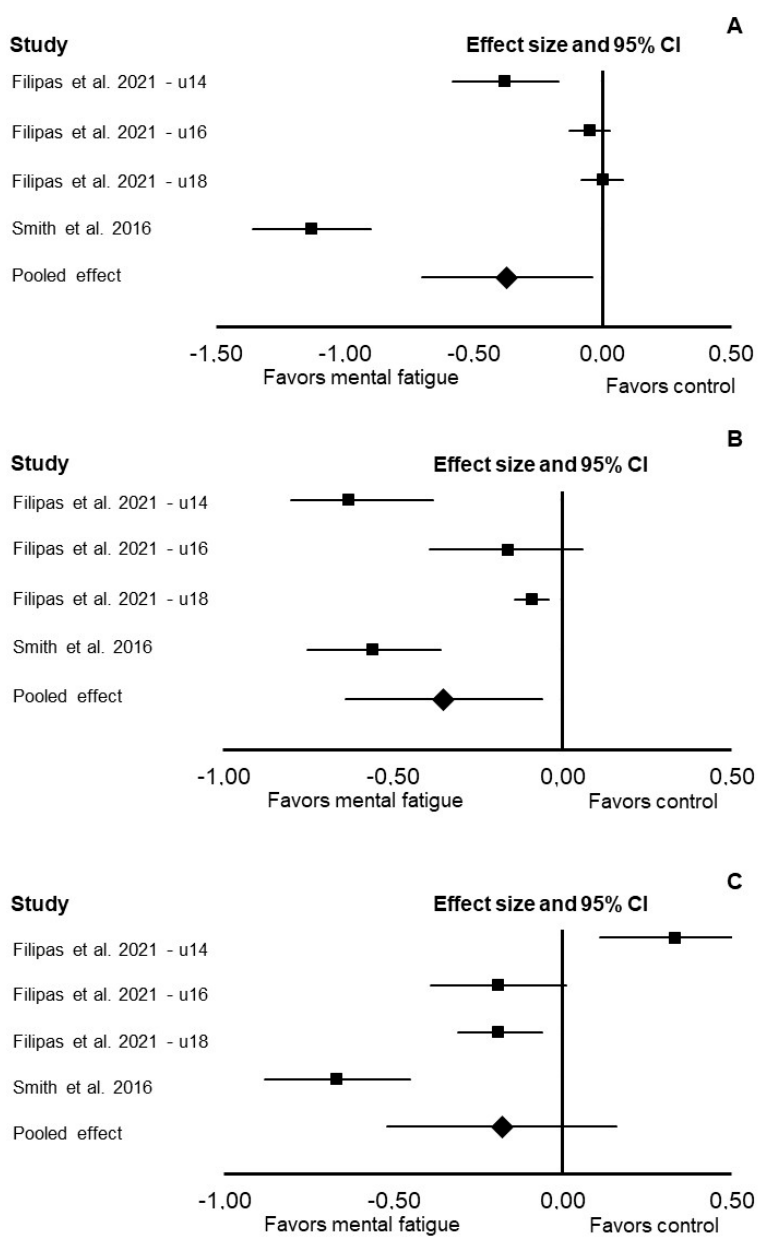
Figure 4. Forest plot presenting the results of the random-effects meta-analysis comparing the effects of control vs. mental fatigue on points per shot ( A ), shot speed ( B ), and shot sequence time ( C ) in the Loughborough soccer shooting test. Data are reported as Cohen’s d (effect size) and 95% confidence interval (CI). The diamond at the bottom presents the overall effect. The plotted squares denote effect sizes, and the whiskers denote their 95% CIs.